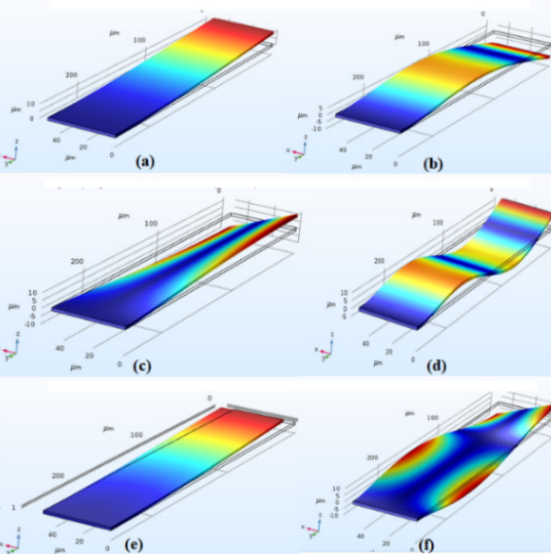
Figure 6. Deflection of microcantilevers for different modal analysis of microcantilevers with length L = 250 µ m, T = 2 µ m. ( a ),( b ),( c ),( d ),( e ) and ( f ) are first, second, third, forth, fifth and sixth mode shape of cantilever when is